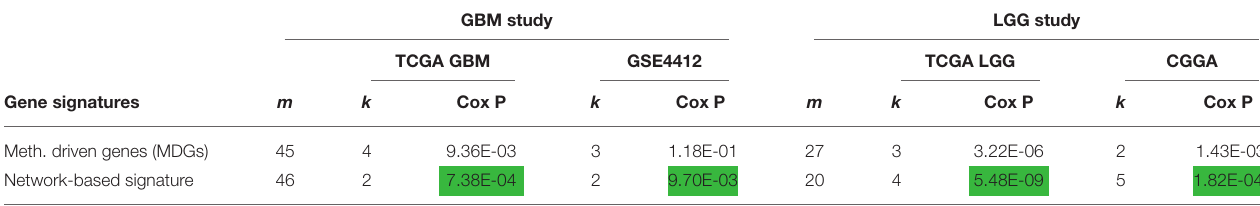
TABLE 3 | Prognostic performance of network-based signatures vs. individual markers.